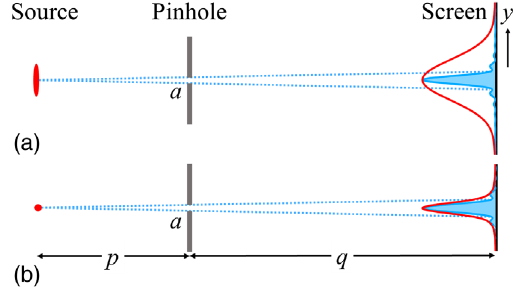
FIG. 1. Schematic of a pinhole imaging system. (a) shows a relatively large source size and its profile on the detector in red. The blue profile is the point spread function of the pinhole for a point source [shown in both (a) and (b) for reference]. (b) shows a small source that might be expected from an MBA-type lattice. Note that the source size effects are comparable to the point spread detector system [6]. Assuming all contributions are Gaussian shape functions, the root mean square (rms) size of each contribution can be added in quadrature.